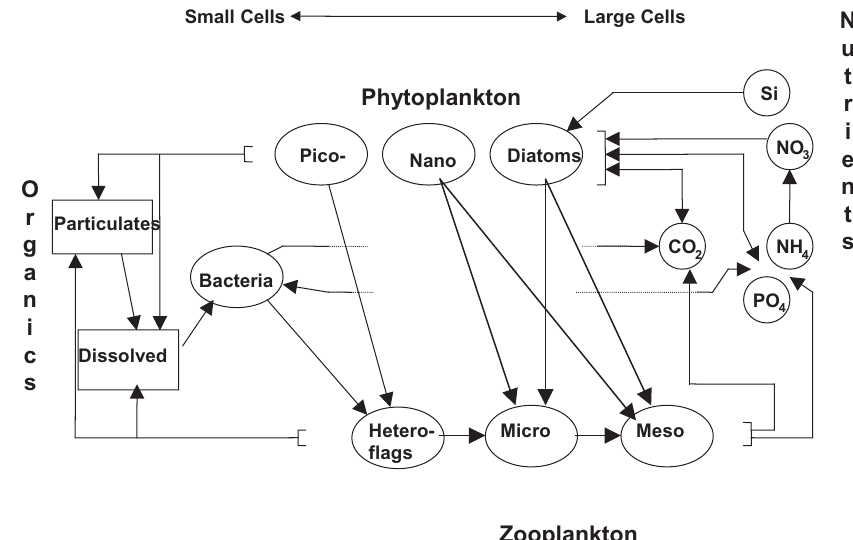
Fig. 1. Schematic diagram of the pelagic food web of the ERSEM